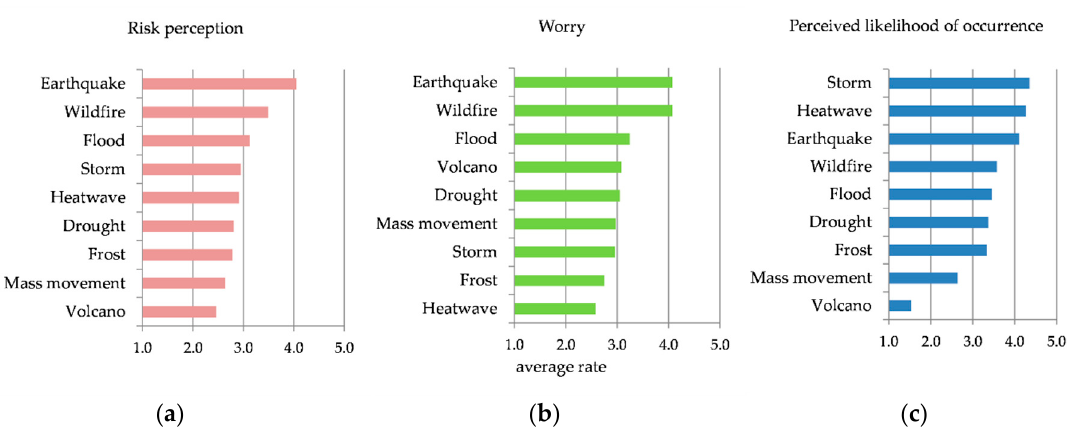
Figure 1. Average ratings assigned by the participants to the nine types of natural hazards survey, with regard to: ( a ) Risk perception in terms of importance, ( b ) feelings of worry they create, ( c ) perceived likelihood of occurrence.